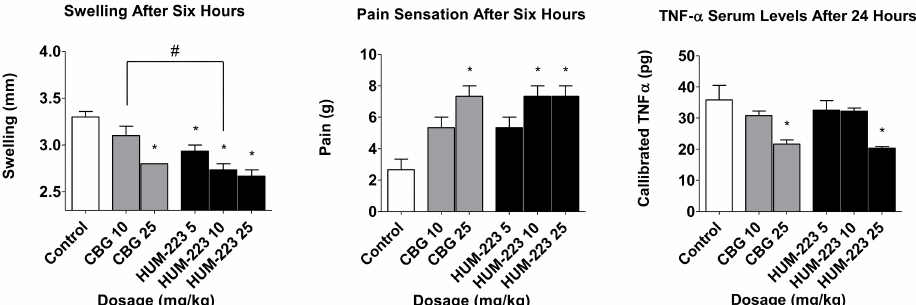
Figure 3. Anti-inflammatory and analgesic evaluation of HUM-223 (black) compared to CBG (cannabigerol) (grey) and vehicle control (white). Statistical comparison was done by 1-way ANOVA ( p -value = 0.0002) and post hoc analysis by Tukey’s test. * p < 0.05 comparing to control group. # p -value < 0.05 in the indicated comparison.